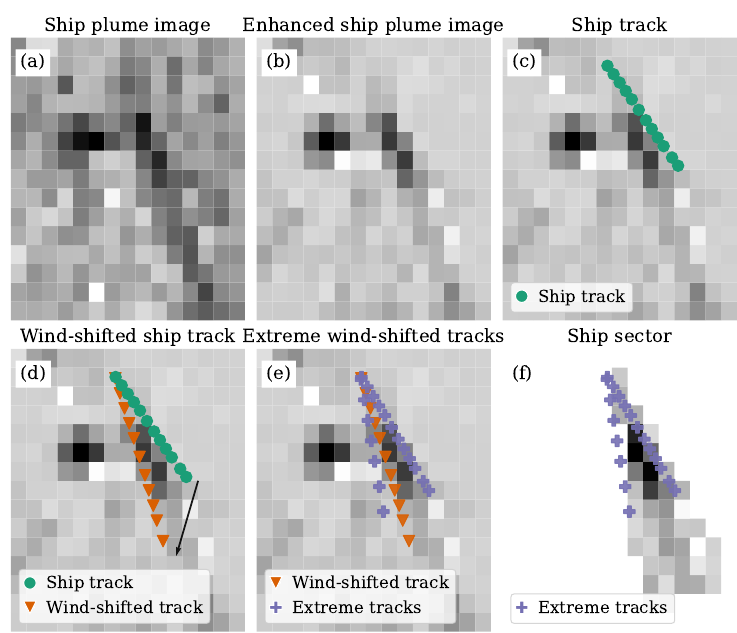
Figure 5. Ship sector definition pipeline. ( a ) Ship plume image —the TROPOMI NO 2 signal for the area around the analyzed ship. Two ship plumes can be distinguished, but only one is of interest. ( b ) The NO 2 signal enhanced by Moran’s I spatial auto-correlation statistic. ( c ) Ship track —estimated, based on AIS data records. The ship track is shown for the time period starting from 2 h before the satellite overpass until the moment of the satellite overpass. ( d ) Wind-shifted ship track —a ship track shifted in accordance with the speed and direction of the wind. The wind-shifted ship track indicates the expected position of the ship plume. A black arrow indicates the wind direction. ( e ) Extreme wind-shifted ship tracks —calculated, based on wind information with assumed uncertainties; define the borders of the ship sector . ( f ) A resulting ship sector —an ROI of an analyzed ship. For all presented images, the size of the pixel is equal to 4.2 × 5 km 2